Question: In one sentence, what is this figure communicating?
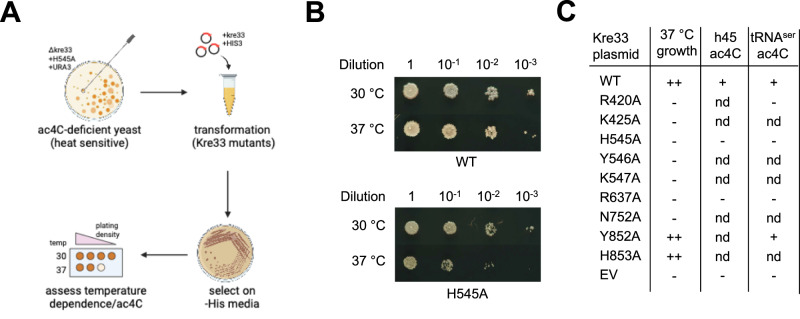
Answer: In vivo assessment of conserved NAT10 residues by functional complementation. A Scheme for yeast functional complementation assay. Assays were performed in a parent yeast strain (Δkre33 + pSH35) in which the endogenous kre33 allele has been deleted replaced with a Sc Kre33 H545A ( Sc H545A, corresponding to Ct H548A) variant. The lack of Kre33 catalytic activity causes this strain to exhibit a growth defect at high temperatures 7 . Yeast were transformed individually with the kre33 plasmids expressing the indicated mutants under TDH3 control with a His3 selection marker. Transformants were grown on -His media and transformation confirmed by PCR amplification and sequencing. Serial 10-fold dilutions were plated on YPD media and incubated for 2 d at the indicated temperatures to assess rescue of temperature-sensitive growth. Created in BioRender. Thalalla Gamage, S. (https:BioRender.com/489v597). B Validation of assay demonstrating that temperature-sensitive growth is rescued by WT Sc Kre33 (top) but not Sc H545A mutant (bottom). Strains were grown, diluted, plated on YPD plates, and grown at the indicated temperatures as described in A. The same experimental strategy was subsequently used for all other mutant variants described in Fig. 5C. C Summary of rescue of temperature-sensitive growth defects and RNA acetylation by Kre33 mutants. ++, complete rescue of growth defect; +, partial rescue of growth defect or RNA acetylation; -, no rescue of growth defect or RNA acetylation. nd = not determined. Growth and RNA acetylation assay data is provided in the Supplementary Information.